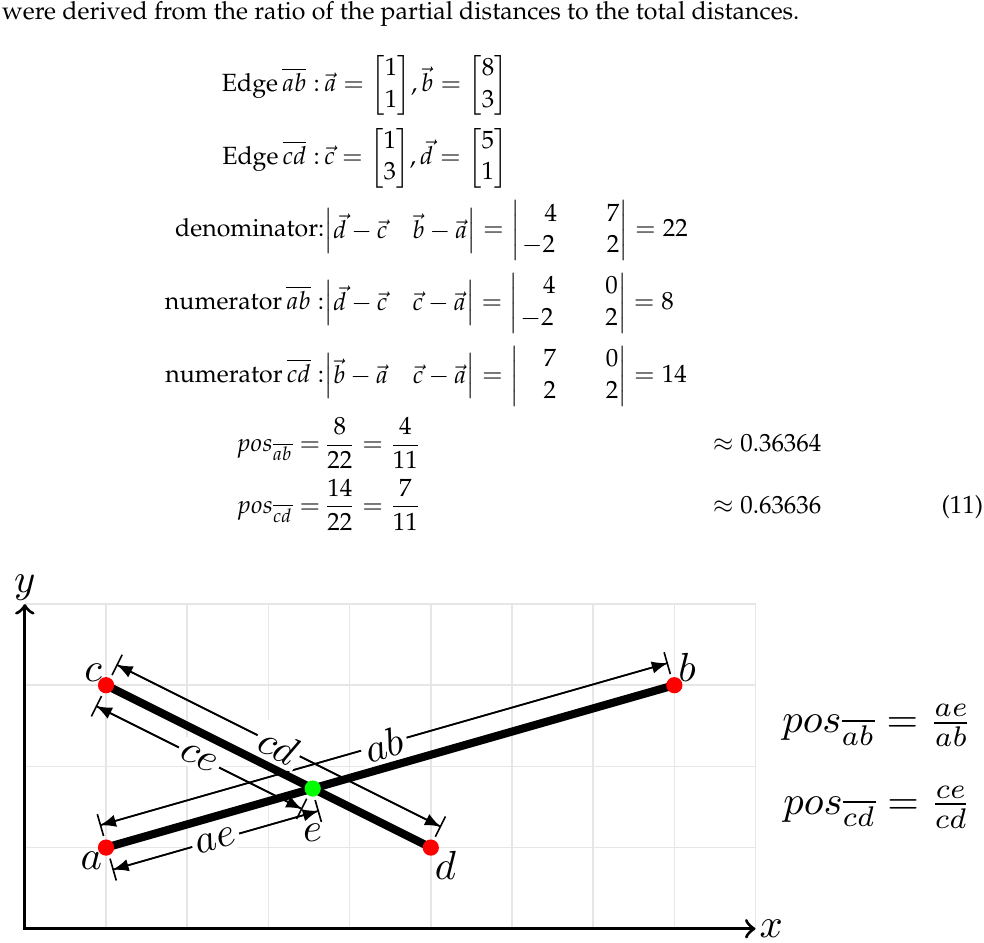
Figure 6. Intersection example of two